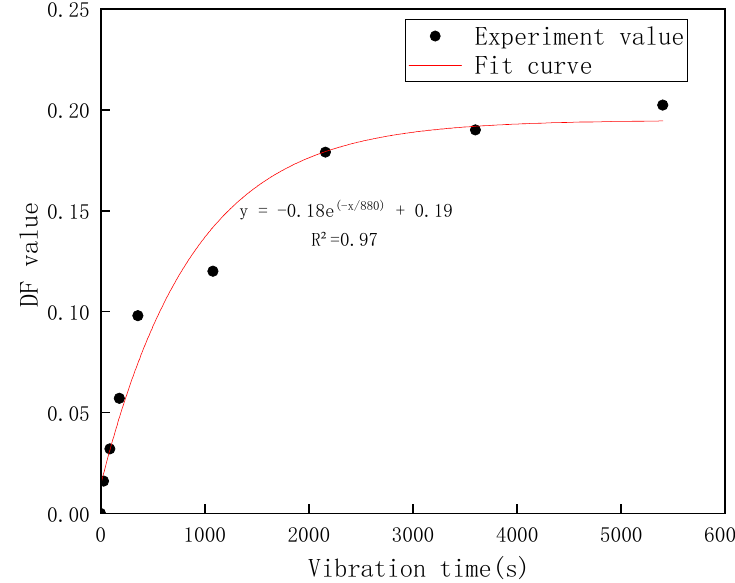
Figure 3. Variation of DF value with vibration time.